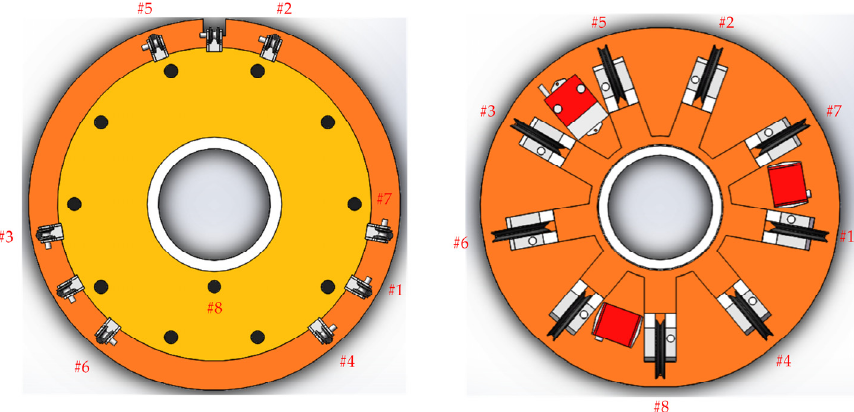
Figure 4. Tension deviation of each strand at di ff erent rotational speeds.